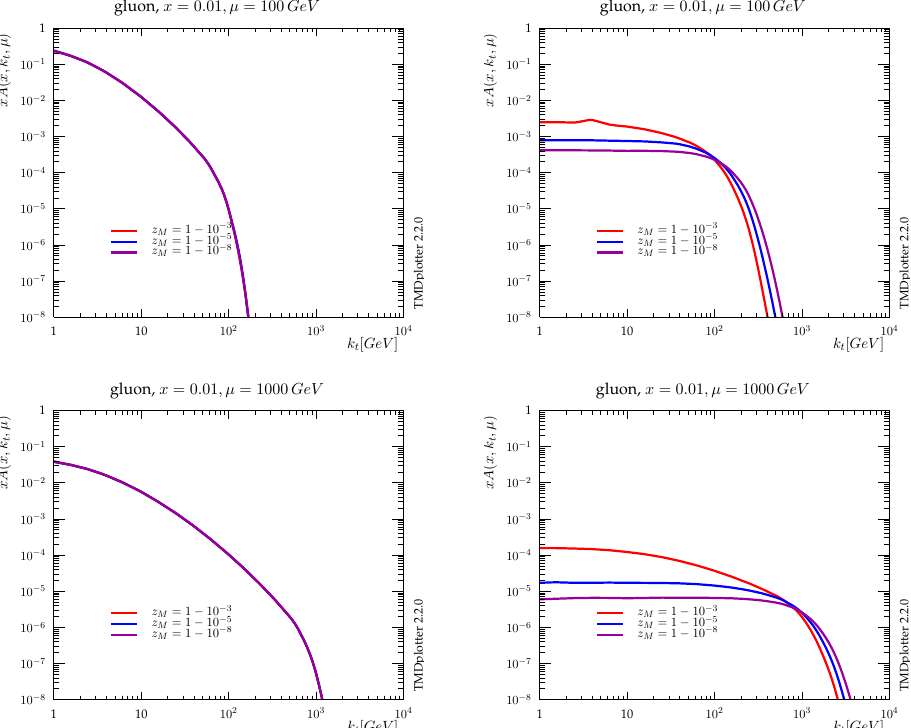
Figure 7 . Transverse momentum gluon distribution versus k t at x = 10 (cid:0) 2 and (cid:22) = 100 GeV (upper row), (cid:22) = 1000 GeV (lower row) for di(cid:11)erent values of the resolution scale parameter z M = 1 10 (cid:0) 3 ; 1 10 (cid:0) 5 ; 1 10 (cid:0) 8 : (left) angular ordering; (right) transverse momentum (cid:0) (cid:0) (cid:0)